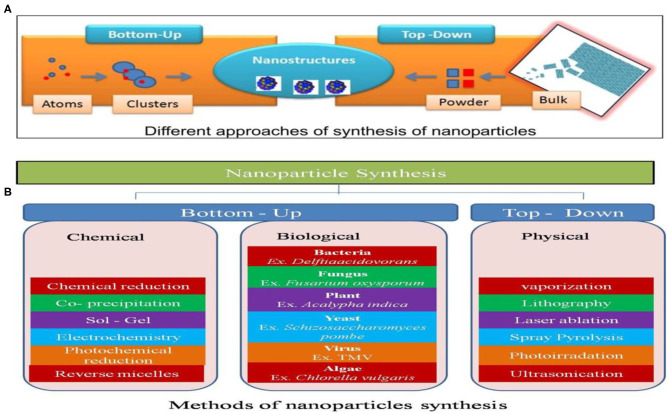
(A,B) Approaches and method of synthesis of nanoparticles.